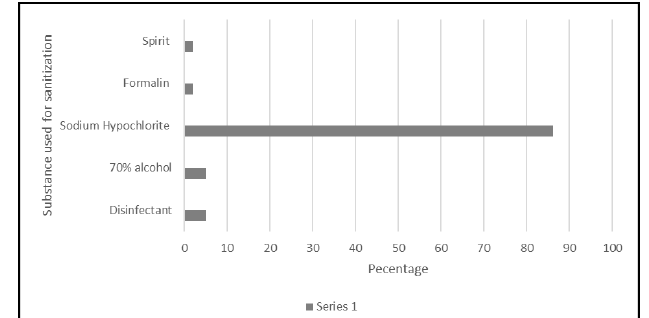
Table 4: Neo – Surgical Check Box